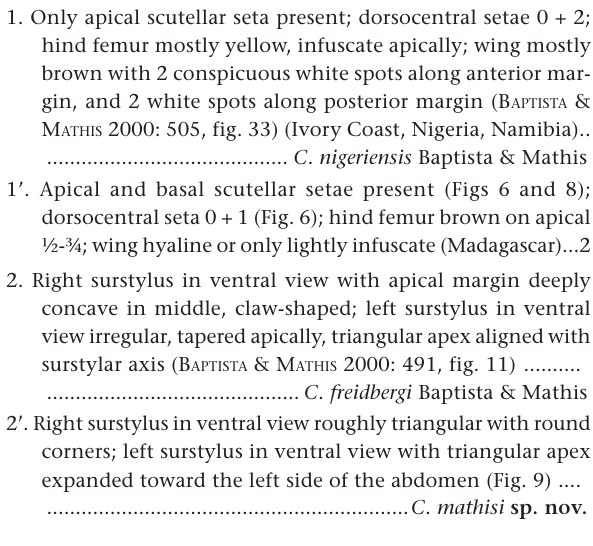
Description. Male (three specimens measured): Adult length 1.9-2.1 mm; wing length 1.7-2 mm; wing width 0.6- 0.75 mm. Head: Ocellar tubercle mostly polished, shiny spot microtomentose, velvet at deepest portion, parafacial